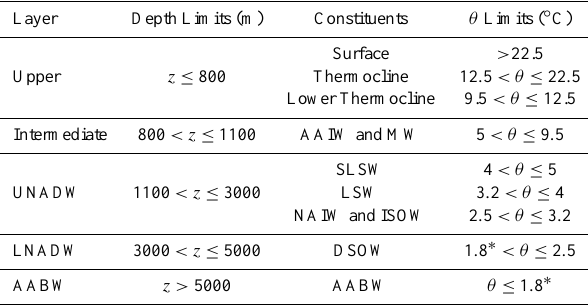
Table 3. Water mass definitions in depth or potential temperature ( θ ) classes reproduced from Longworth (2007), in turn based on the studies of Schmitz and McCartney (1993) and Fine (1995). Note that a potential temperature of 22.5 ◦ C is chosen to sepa- rate surface and thermocline waters following investigations (Atkin- son, 2011) showing this isotherm to be more representative of the base of the seasonal thermocline across the mid-ocean than the 24.5 ◦ C isotherm used by Longworth (2007). Depth layers may contain several water mass constituents which are only identified here in temperature classes. The boundary between LNADW and AABW (1.8*) is variable and set as the shallowest occurrence of northward transport within 0.05 ◦ C intervals (1.85 ◦ C, 1.70 ◦ C,